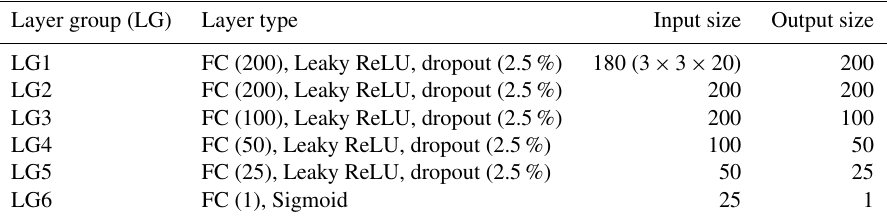
Table 4. The architecture of the NNCM. LG refers to layer group and is used to describe the collection of layers in each row. FC ( x ) refers to the fully connected layers, where x is the number of units in each layer. Similarly, dropout ( x ) refers to the fraction of inputs to which dropout is